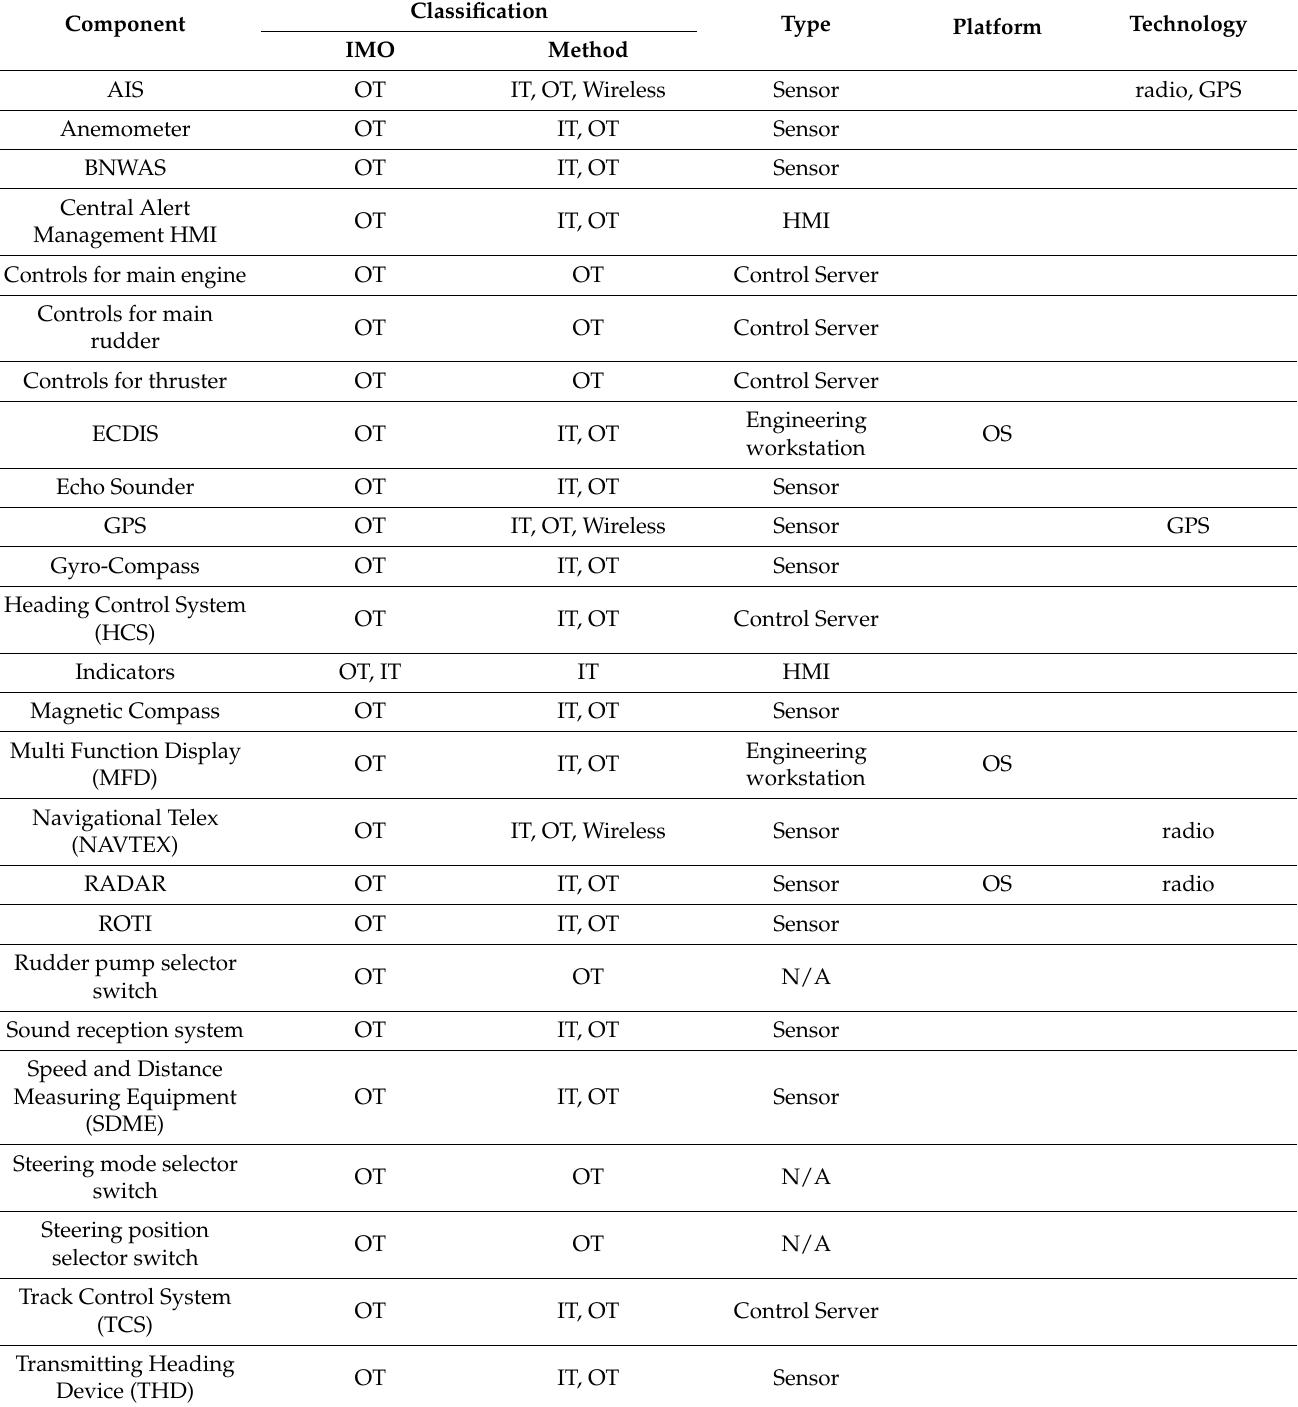
Table 2. Components and classification of